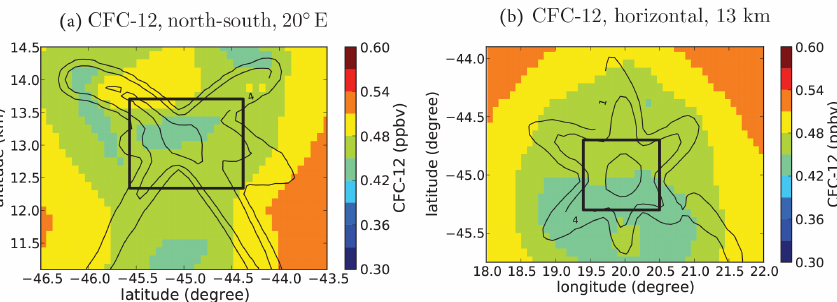
Figure 19. Retrieved CFC-12 mixing ratios at 20 ◦ E (left) and 13km altitude (right) for 13:30–14:30UTC, 13 September 2012. For details see caption of Fig.